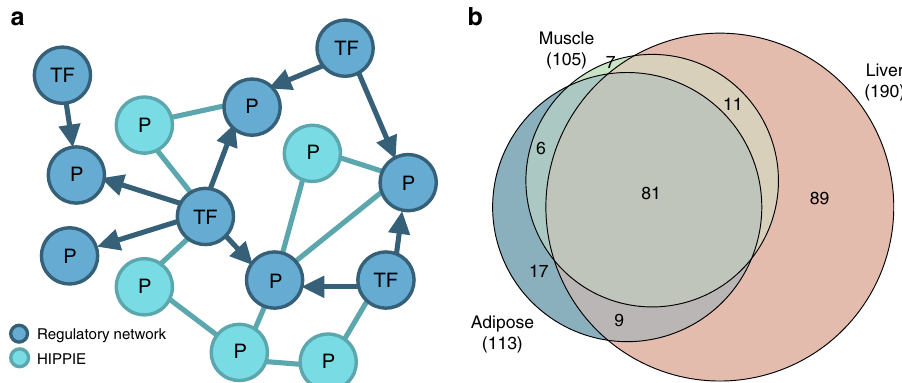
Fig. 3 Network construction and disease module identi fi cation. a Tissue-speci fi c networks were constructed by integrating transcriptional regulatory networks consisting of interactions between transcription factors and genes (blue nodes) and PPI networks including interactions among proteins (turquoise nodes). For each tissue, the integrated network was built starting from the high-evidence associations from the regulatory network and extended with high-score interactions from the PPI network. b Venn diagram of shared MetSyn genes among the three tissue-speci fi c networks. See also